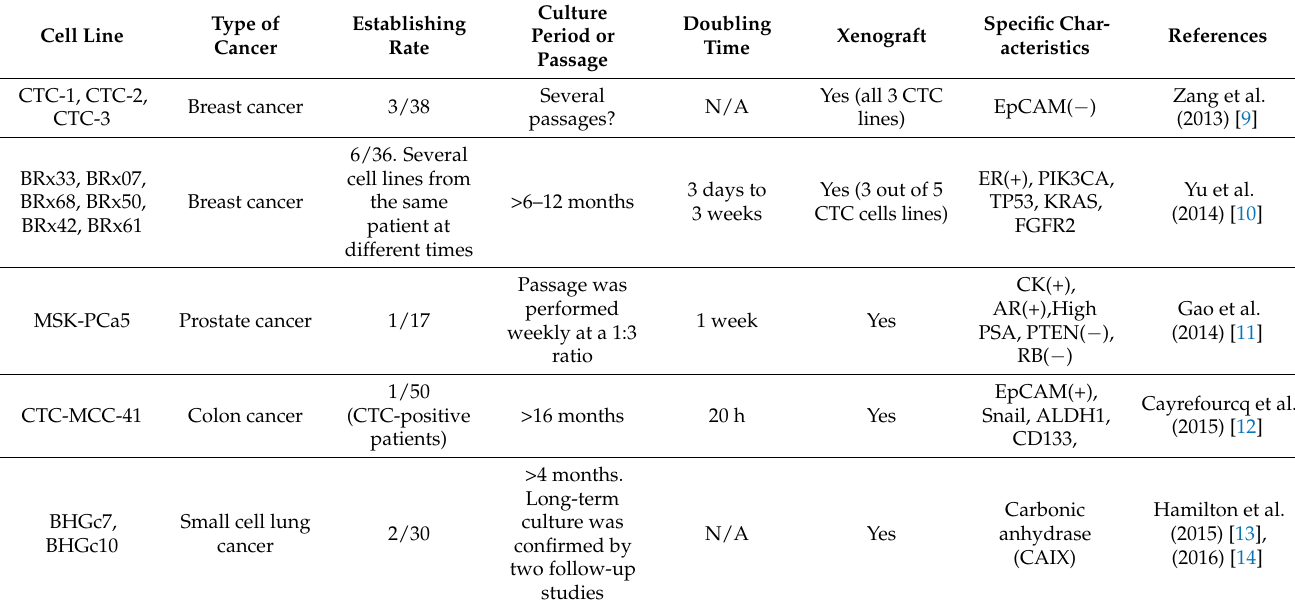
Table 1. Summary of CTC cell